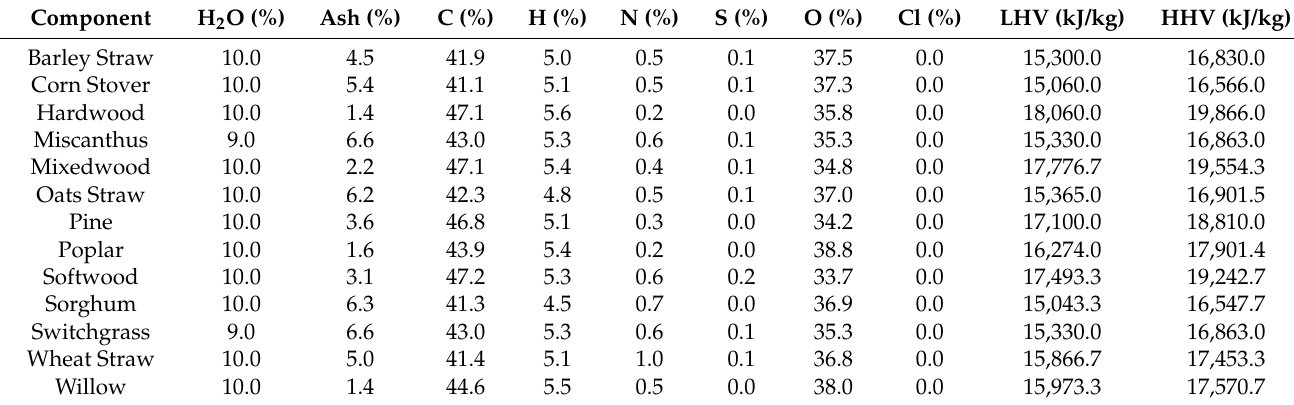
Table A3. Proximate analysis of pelletized biomass feedstocks used for PBC and IBGCC simulations. Component